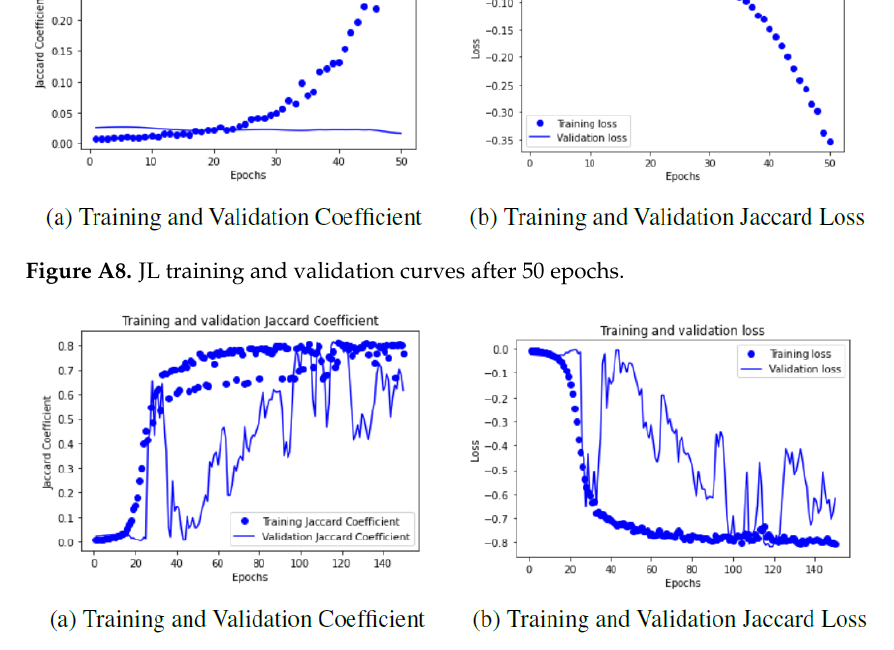
Figure A9. JL training and validation curves after 150 epochs.